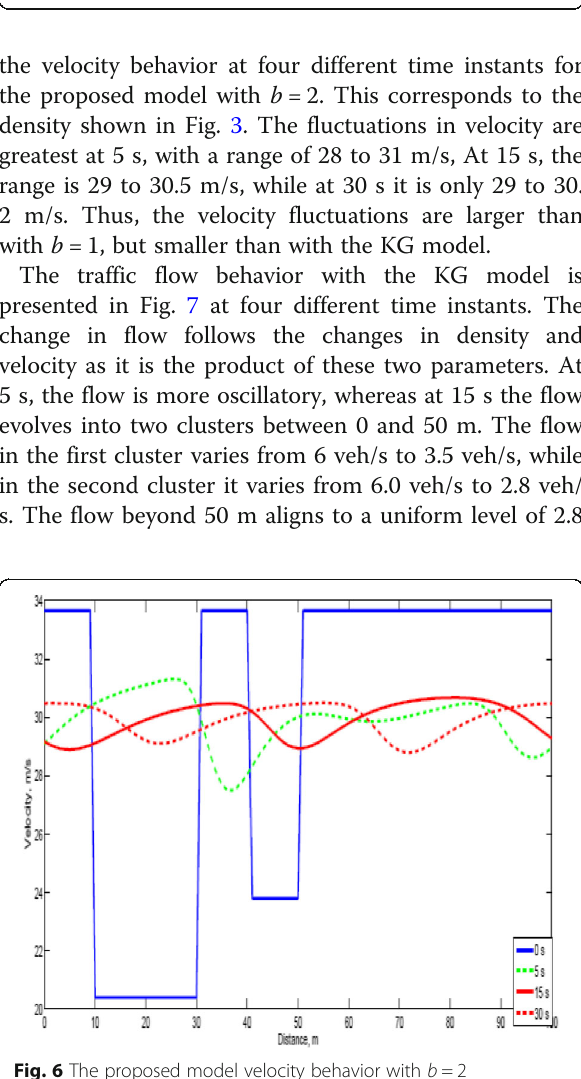
Fig. 5 The proposed model velocity behavior with b = 1